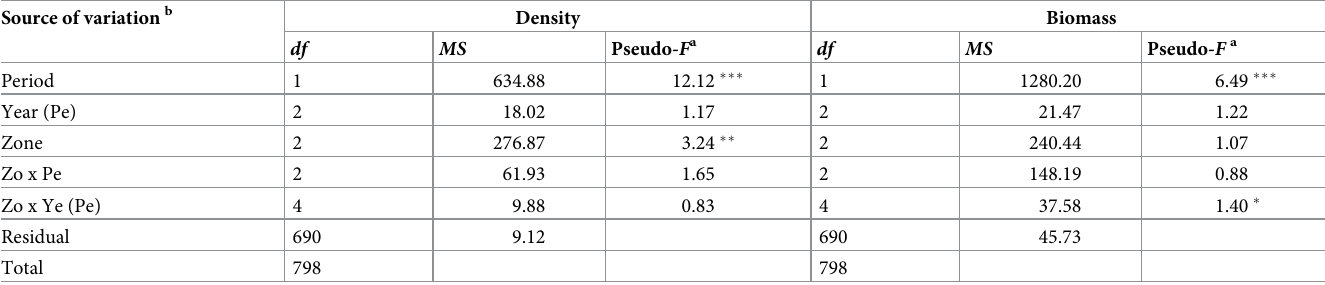
Table 5. Summary of multivariate PERMANOVA (LPNR).